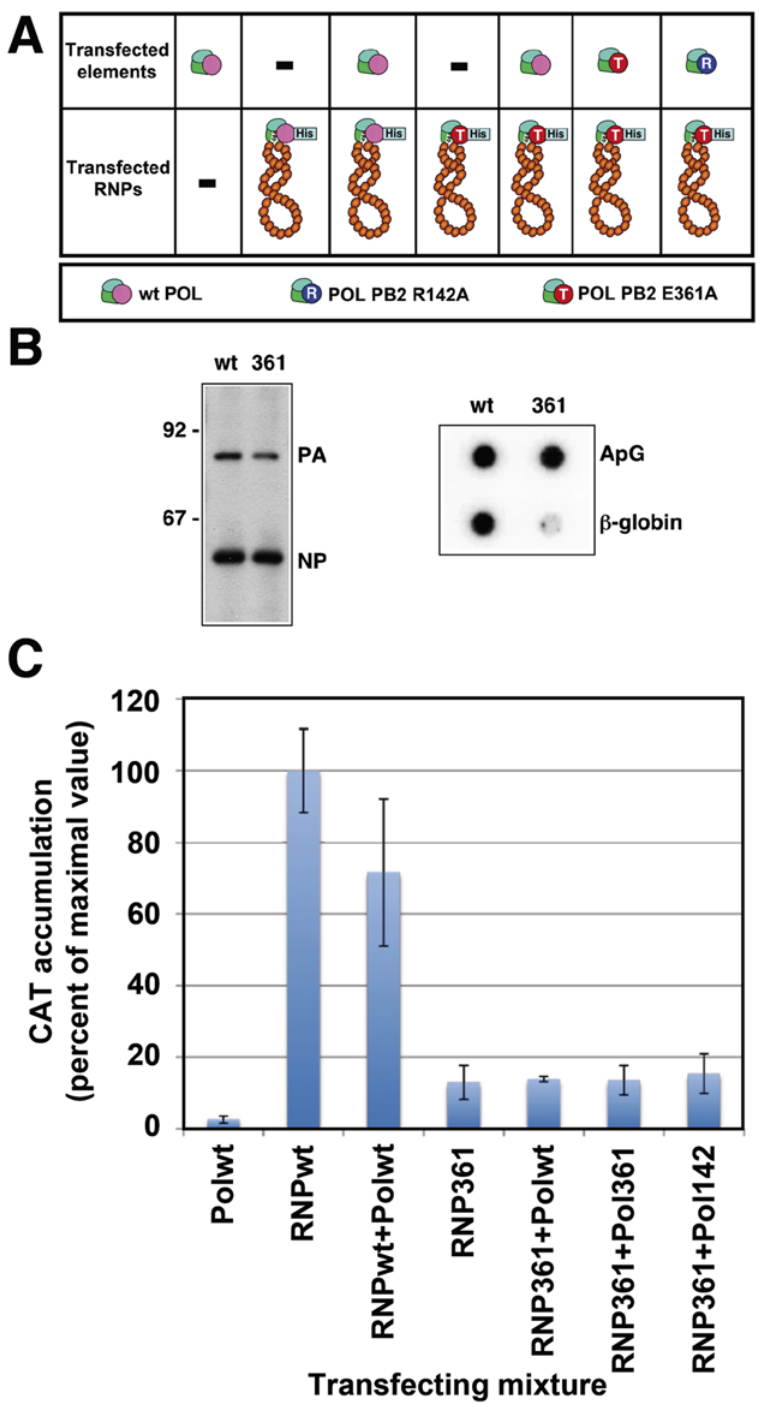
Figure 7. Lack of transcription of RNPs by a soluble polymerase complex intrans . (A) Cultures of HEK293T cells were transfected with plasmids expressing various combinations of the polymerase subunits as indicated in the diagram. In some cases, purified cat RNPs containing wt or transcription-deficient polymerase were also transfected. (B) Left panel. The amount of wt (wt) or transcription deficient (361) RNPs transfected was ascertained by Western-blot with anti-NP and anti-PA antibodies. The mobility of molecular weight markers is shown to the left and the position of PA and NP proteins is indicated to the right. Right panel. The transcription phenotype of the RNPs transfected was determined by in vitro transcription using ApG (ApG) or b -globin mRNA ( b -globin) as primers. The panel shows the phosphorimager data. (C) The amount of CAT protein accumulated in the cells was determined by ELISA. The data are presented as percent of the value obtained by transfection of purified wt RNPs and represent the average and standard deviation of six independent experiments. The 100% value represented corresponds to a concentration of 340 pg/ml of CAT protein.